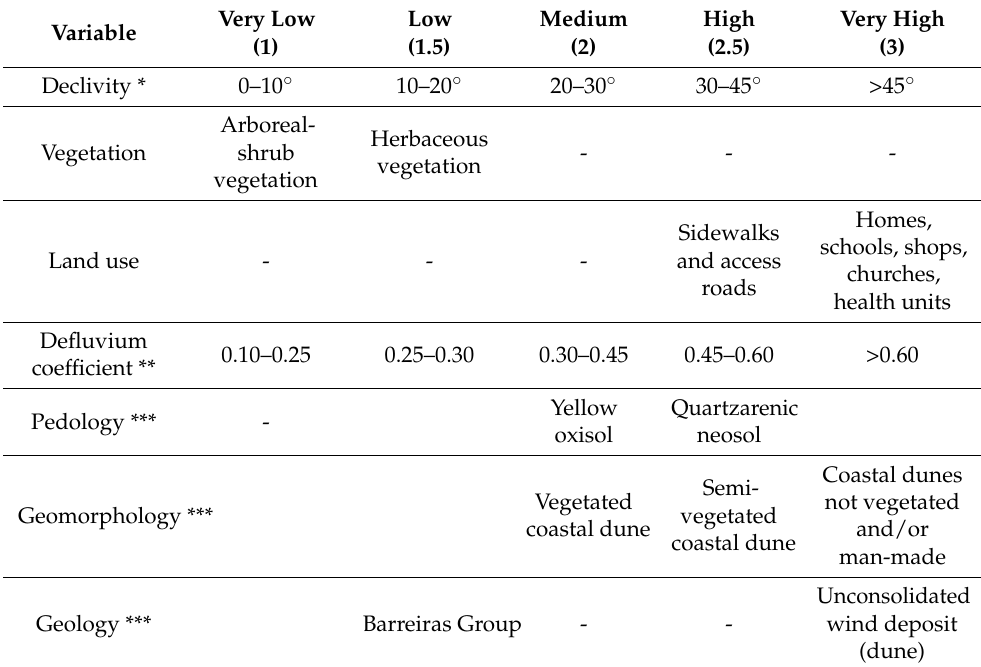
Table 4. Weights for the classes of environmental variables included in the calculation of landslide vulnerability in the district of M ã e Luiza, Natal,